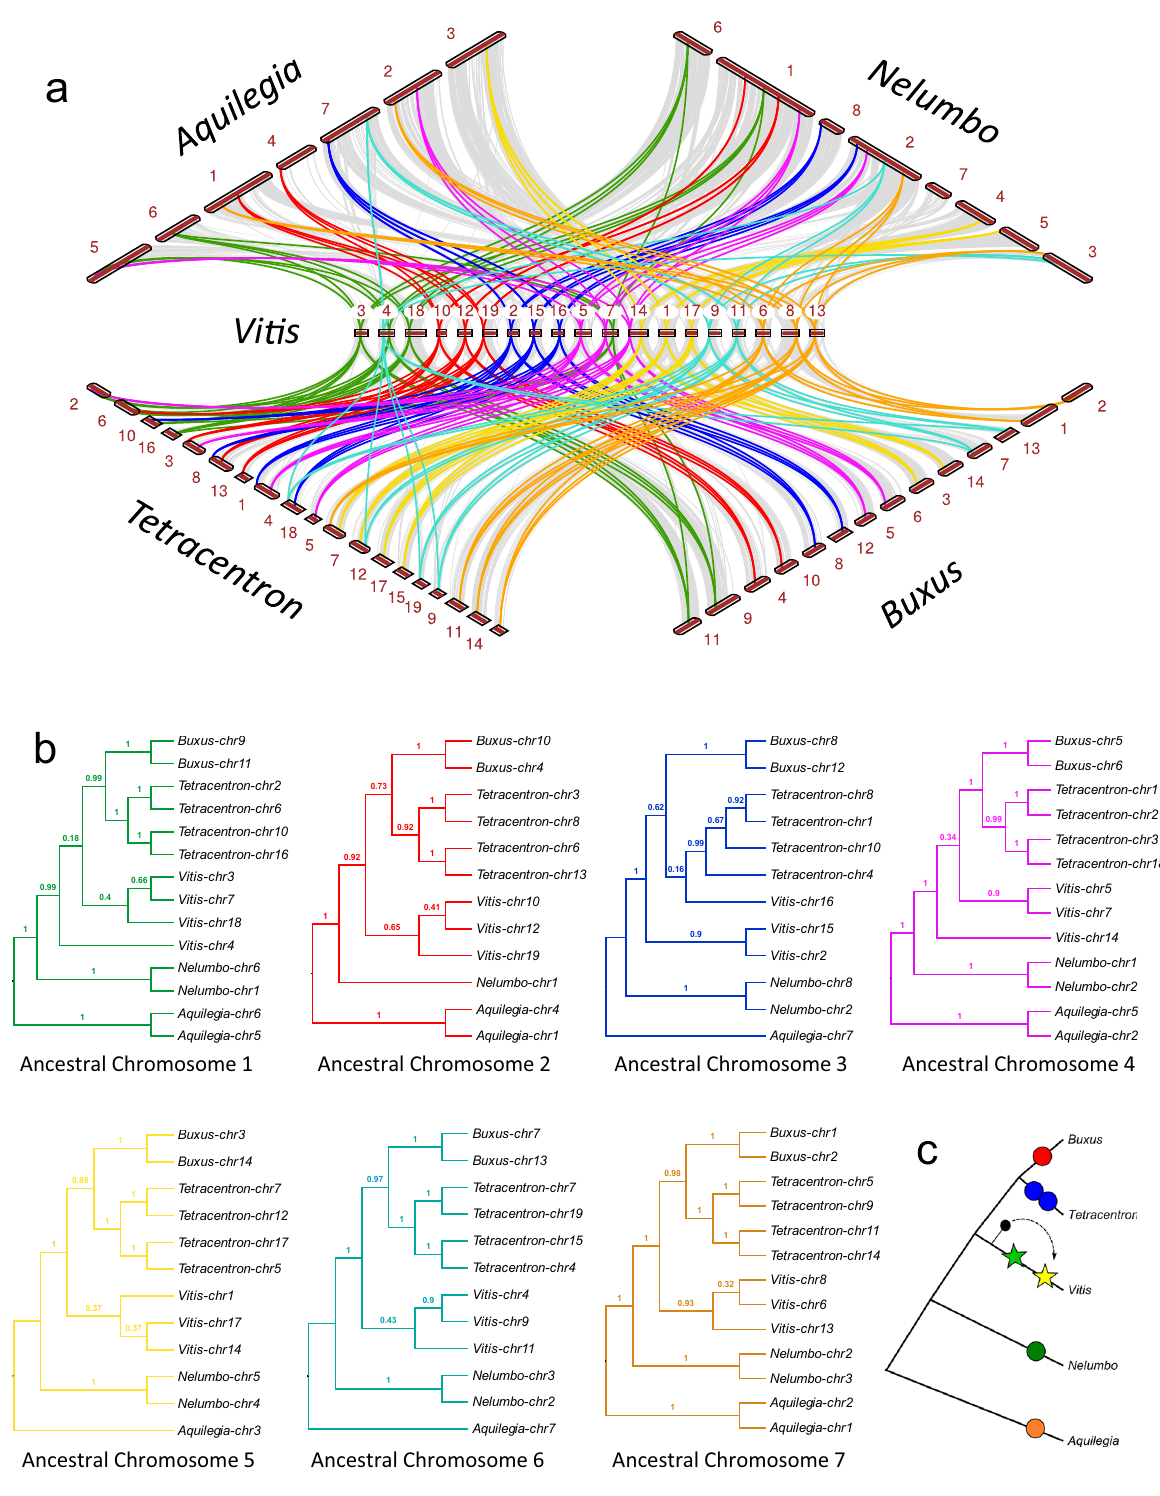
Fig. 3 Synteny and phylogenomics of eudicot subgenomes. a Macrosyntenic alignments of early-diverged eudicots against Vitis with tracking of genomic positions by color-coded syntenic blocks representing the seven ancestral eudicot chromosomes. b Coalescence-based phylogenies of syntelogs derived from duplication events affecting the seven ancestral eudicot chromosomes. Green, red, blue, purple, yellow, aqua, and brown tracks highlight positions of ancestral chromosomes 1 through 7, respectively. Branch labels are posterior probabilities. c Schematic reconstruction of ancient eudicot WGD history. Differently color- fi lled circles label putative independent duplication events and stars highlight the two gamma WGDs in which the third genome is donated to the initial tetraploid (green star) from an extinct lineage to form the hexaploid (yellow star). Source data underlying Fig. 3a are provided as a Source data fi